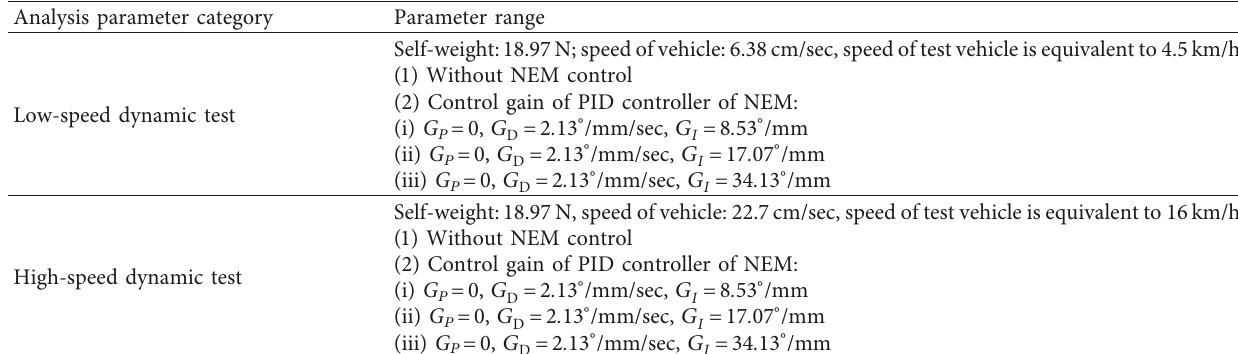
Figure 10: Experimental framework of overall reduced-scale bridge with NEM. Table 3: Experimental parameter setting of this